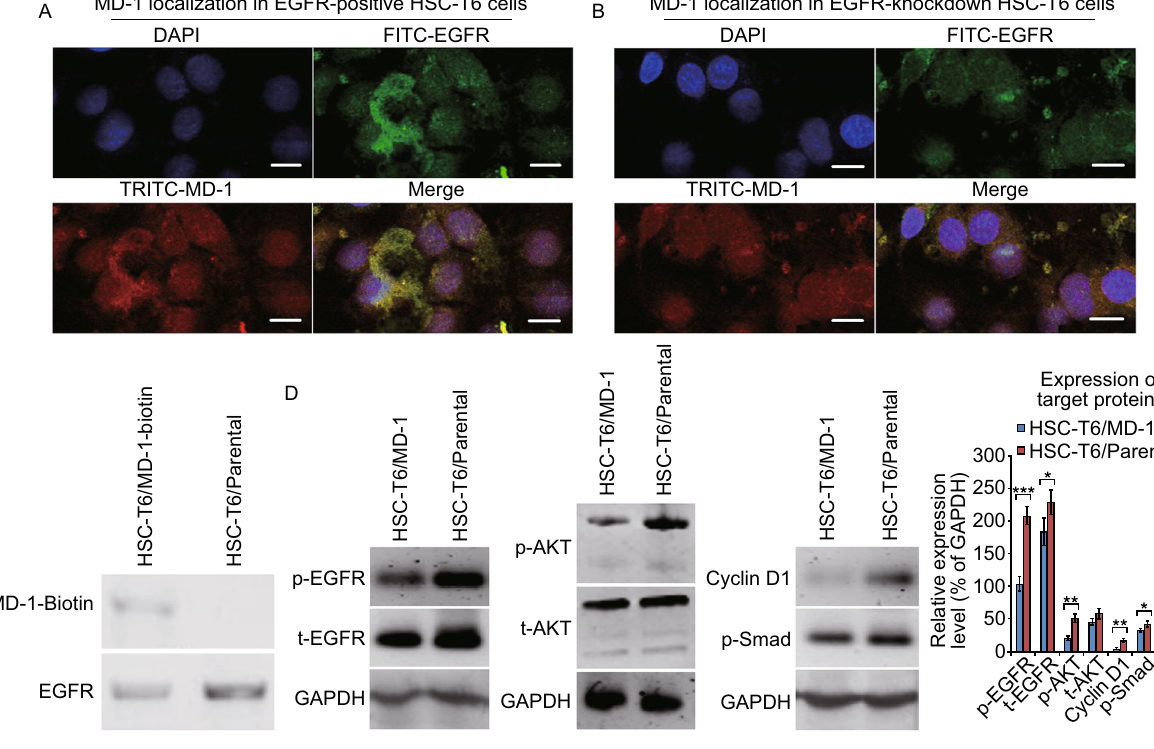
Figure 4. Inhibitory effects of MD-1 on the EGFR signaling pathway in HSC-T6 cells. (A) Immunostaining of EGFR-positive HSC-T6 cells showed MD-1 localization. Nuclei are stained with DAPI. Scale bar: 10 µm. (B) Similar to (A), but in EGFR-knockdown HSC-T6 cells. Scale bar: 10 µm. (C) Co-immunoprecipitation blots showed MD-1-Biotin was precipitated by EGFR in the MD-1- treated HSC-T6 cells, but not in the parental cells. (D) Representative Western blots to show the expression of EGFR, AKT, cyclin D1, and p-Smad. GAPDH was used as the loading control. Densitometry was performed to determine the relative expression levels normalized to GAPDH. * P < 0.05; ** P < 0.01; *** P < 0.001.